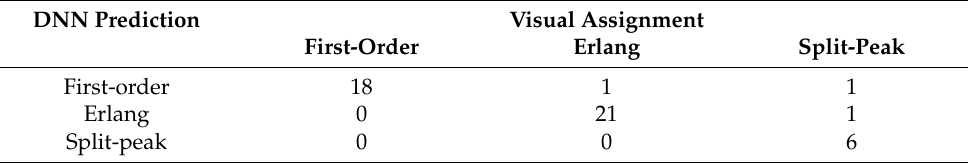
Table 3. Confusion matrix presents the classification of the external patient